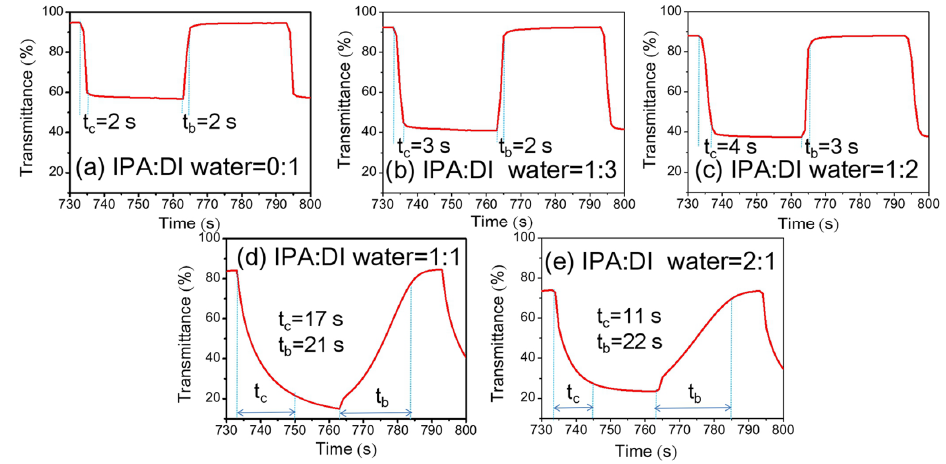
Figure 8. Switching curves of NiO x films as a function of the volume ratios of IPA:DI water in NiO x inks: ( a ) 0:1; ( b ) 1:3; ( c ) 1:2; ( d ) 1:1 and ( e ) 2:1. The NiO x films are by spin-coating three times and after 150 °C annealing.